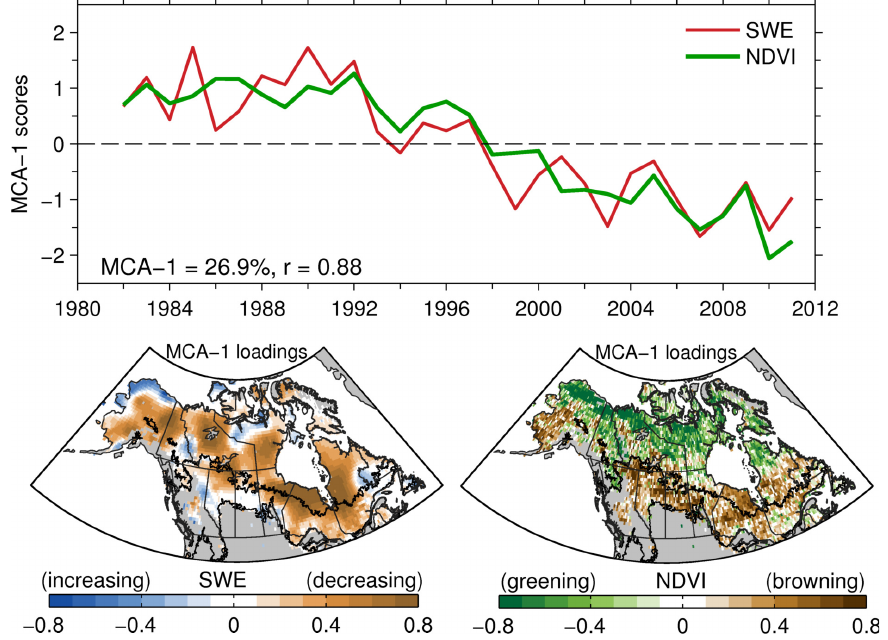
Figure 10. Temporal and spatial patterns of the leading Maximum Covariance Analysis (MCA) mode between maximum SWE and summer NDVI fields in boreal and Arctic regions of North America computed over the period 1982–2011. This mode explains 26.9% of the total cross-covariance and the correlation between the corresponding time expansion coefficients is